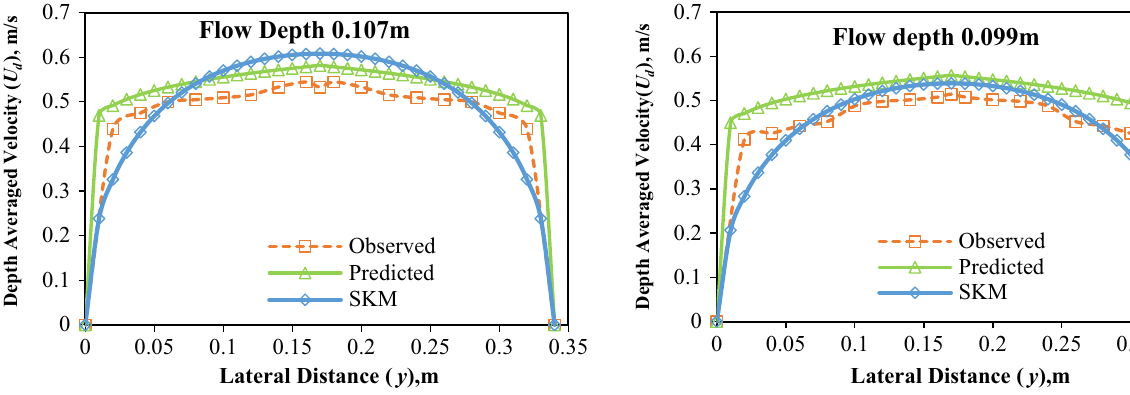
Fig. 9 Depth-averaged velocity of NITR1 series